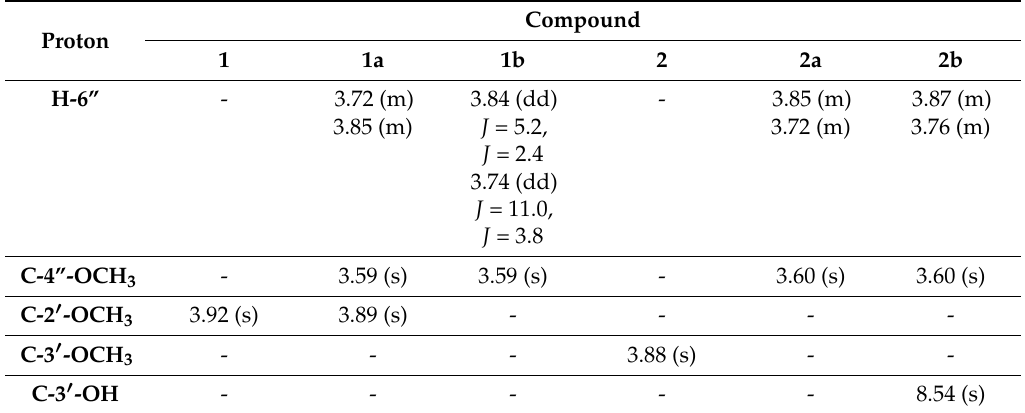
Table 2. The 13 C-NMR shifts ( δ ) (ppm) of 2 (cid:48) -methoxyflavanone ( 1 ) and 3 (cid:48) -methoxyflavanone ( 2 ) and